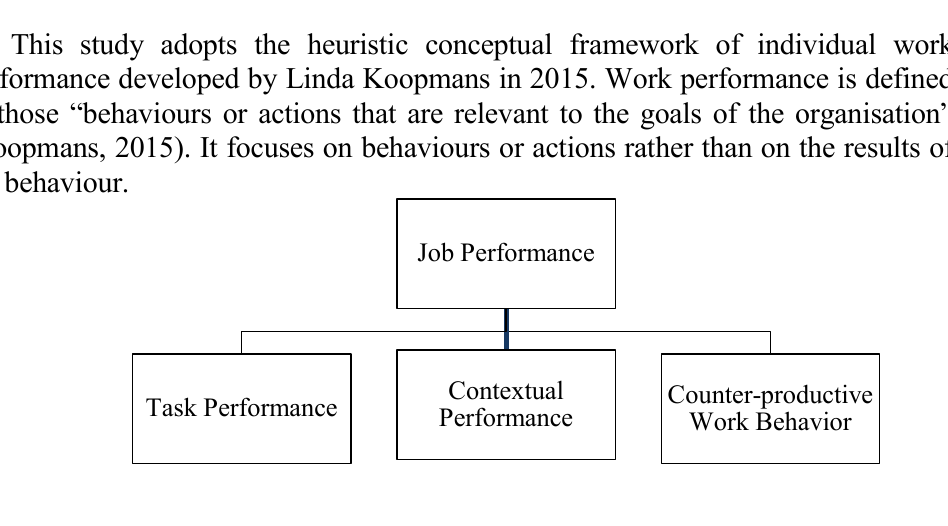
Fig. 1. Individual Work Performance Questionnaire. TNO Innovation for Life – VU University Medical Centre (Koopmans,